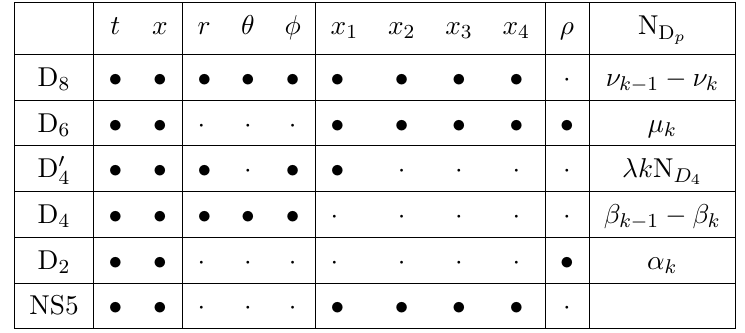
Table 2 . Brane configuration which in the near horizon limit gives the solution in eq. (3.1). We show the world-volume directions the branes are suspended as well as their number in the k-th